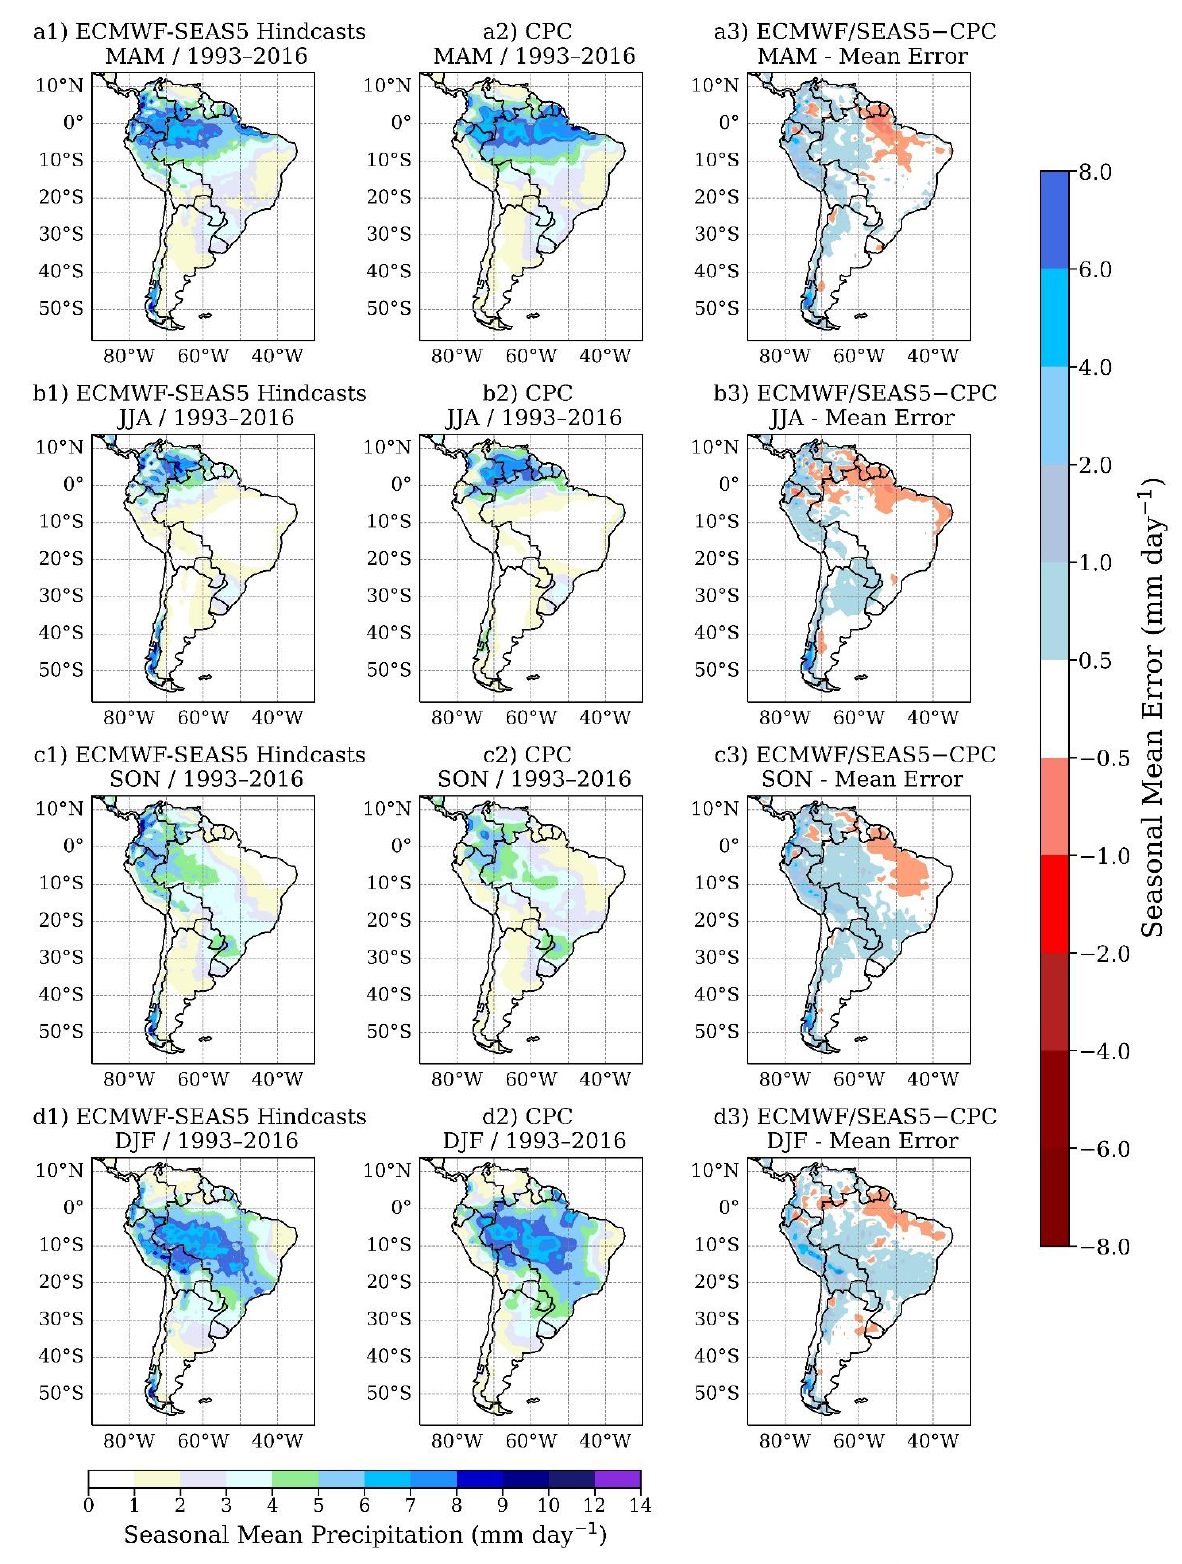
Figure 6. Left column : seasonal mean precipitation (mm day − 1 ) derived from the ECMWF-SEAS5 hindcasts, averaged for 1993–2016 and over the 25 ensemble members, for ( a ) MAM, ( b ) JJA, ( c ) SON, and ( d ) DJF. Center column : CPC seasonal mean precipitation (mm day − 1 ) averaged over 1993–2016. Right column : seasonal precipitation mean errors (mm day − 1 ) obtained by the difference between ECMWF-SEAS5 and CPC and averaged over